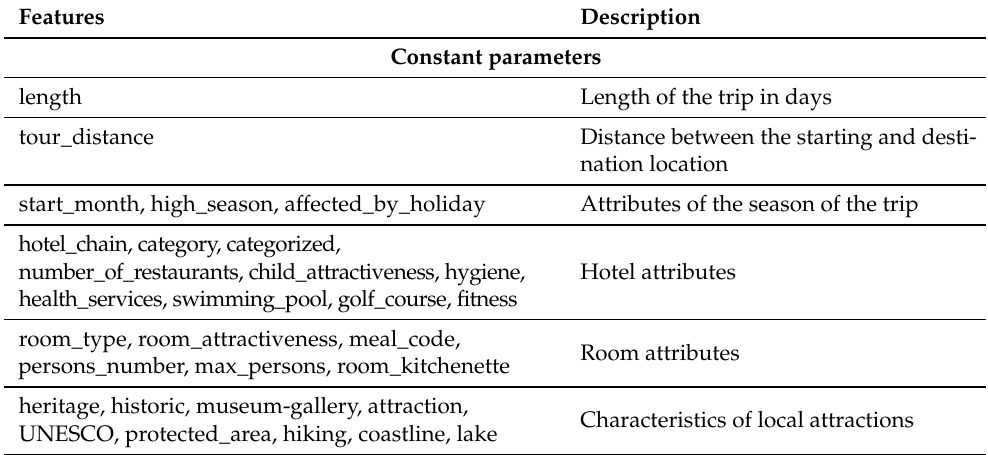
Table 1. Feature